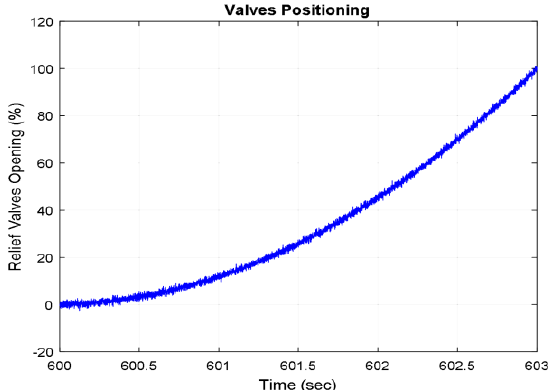
Fig. 15. Valve actuation at first vertex of polytope